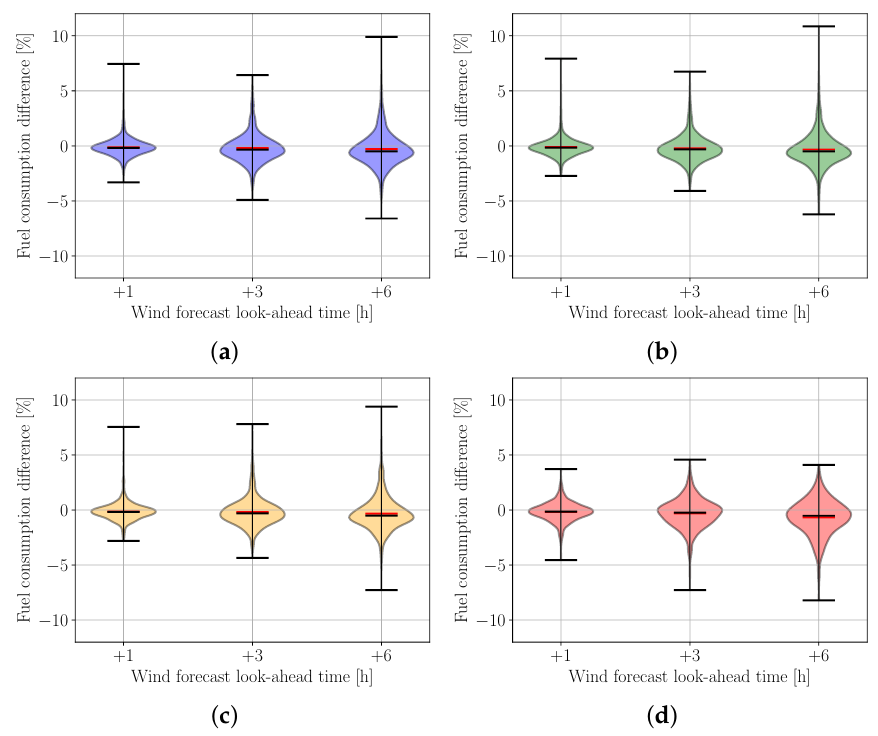
Figure 7. Fuel consumption difference with respect to the initial plan. ( a ) NMPC. ( b ) SbNMPC. ( c ) AsNMPC. ( d ) Open-loop.